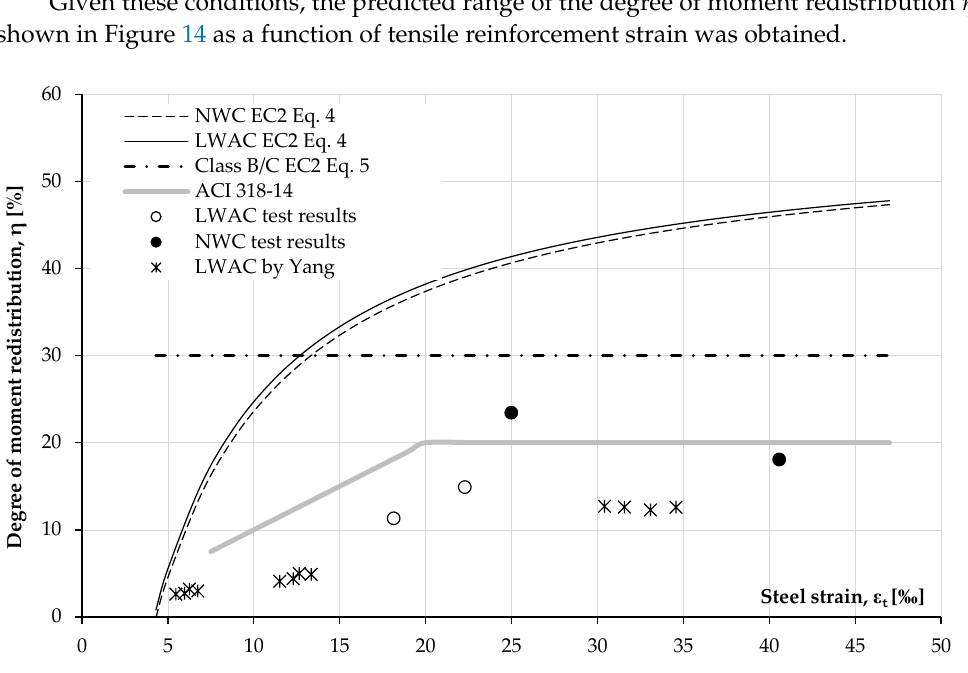
Figure 14. Comparison between the degree of moment redistribution values calculated according to test results (own tests presented below and elements tested by Yang [40]) and those predicted by both Eurocode 2 [39] and ACI 318-105 [43] equations.